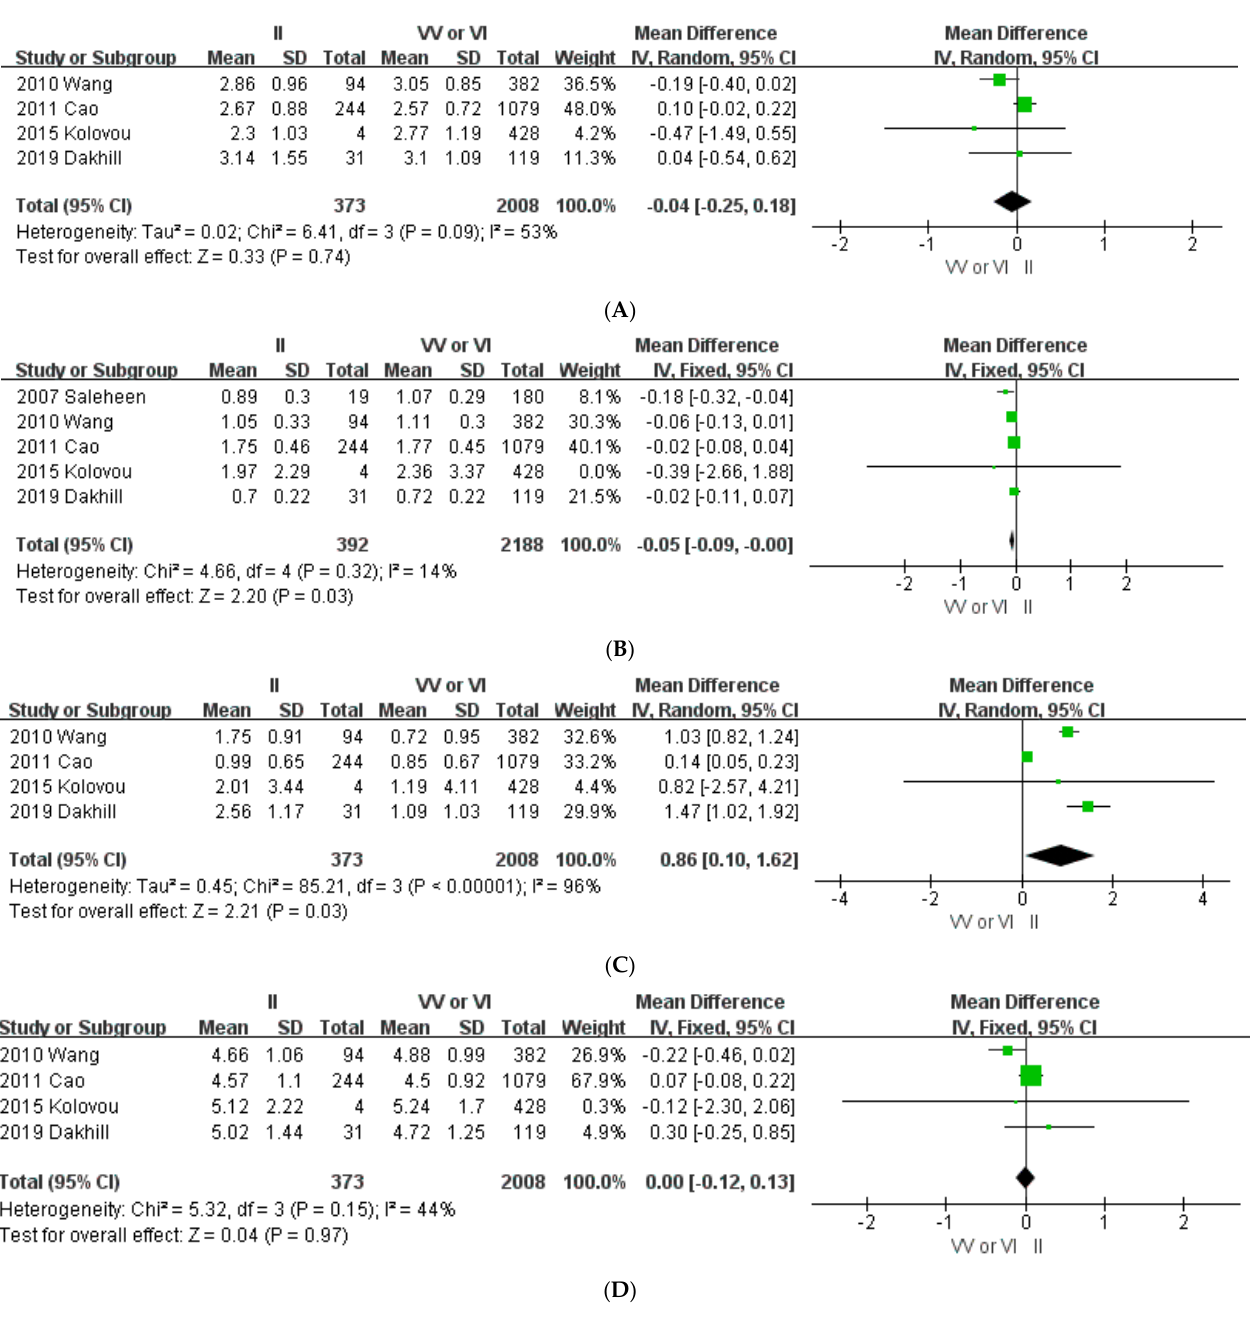
Figure 3. Forest plots demonstrating the association between the ABCA1 825V>I polymorphism and lipid level (mmol/L). ( A ) High-density lipoprotein cholesterol; ( B ) low-density lipoprotein cholesterol; ( C ) triglycerides; ( D ) total cholesterol.